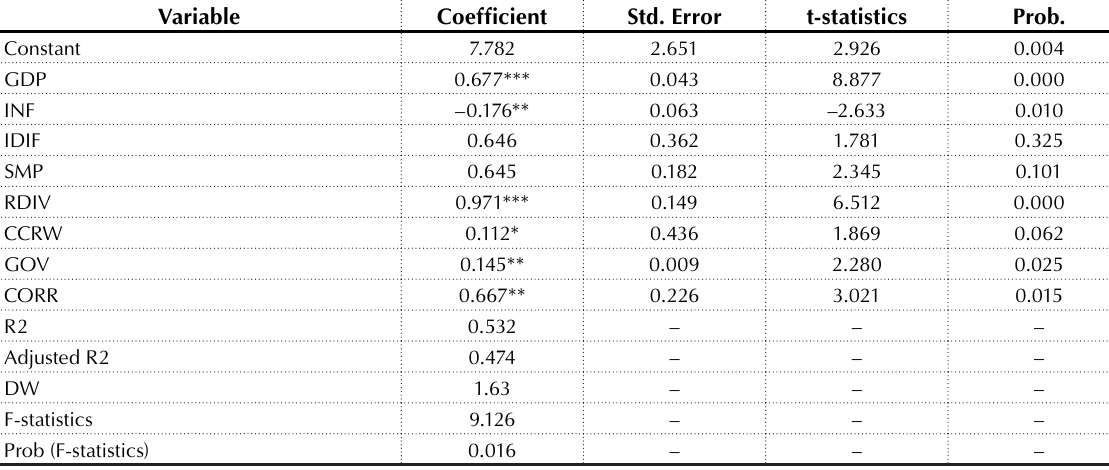
Table 4. Results of OLS regression